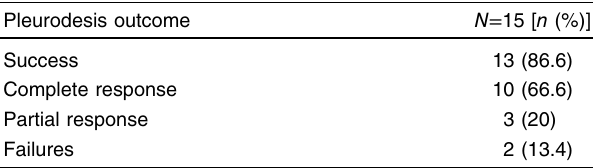
Table 4 Complications and morbidities related to thoracoscopic tetracycline poudrage